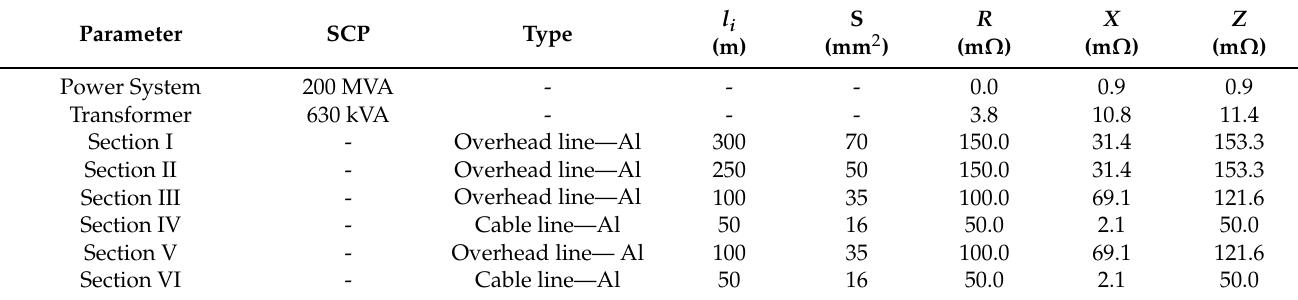
Table 4. Parameters of selected low-voltage power grid configurations with branching radial topology—Line